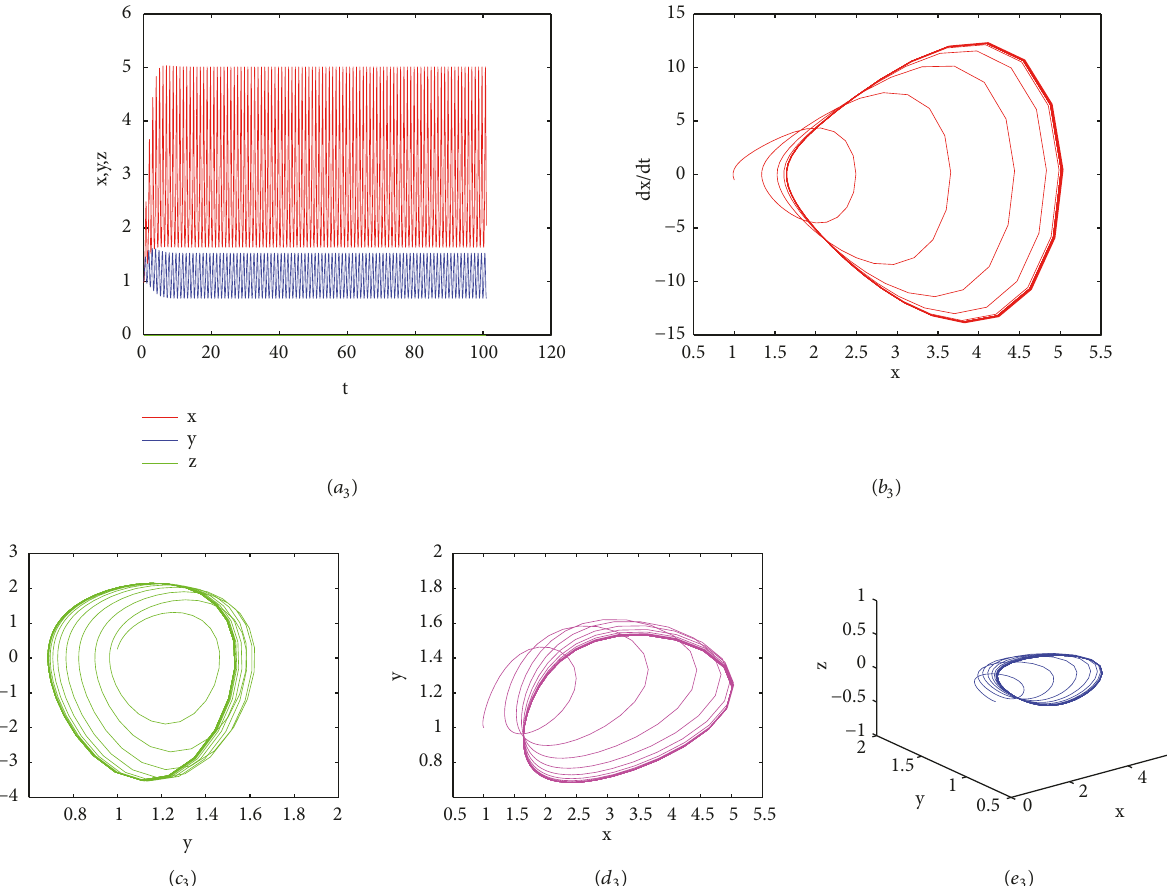
Figure 12: The results of Experiment 6: (𝑎 3 ) time series plot of 𝑥,𝑦, 𝑧 ; (𝑏 3 ) phase diagram of 𝑥 ; (𝑐 3 ) phase diagram of 𝑦 ; (𝑑 3 ) projected on the (𝑥,𝑦) -plane; (𝑒 ) on the three-dimensional 3